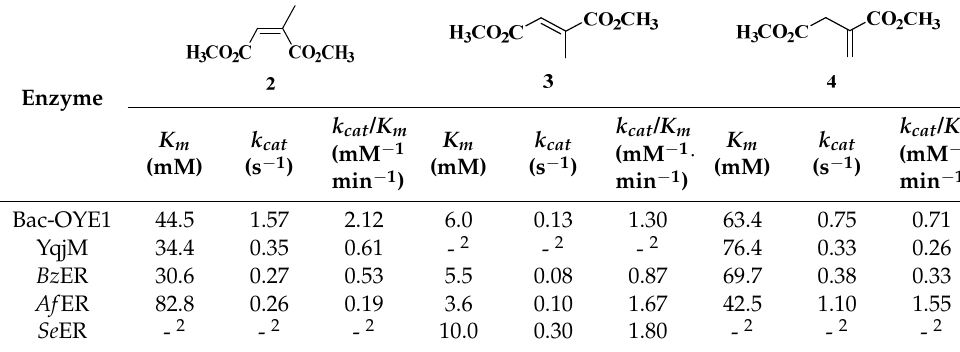
Table 3. Kinetic parameters towards 2 , 3 and 4 substrates for ERs 1 .